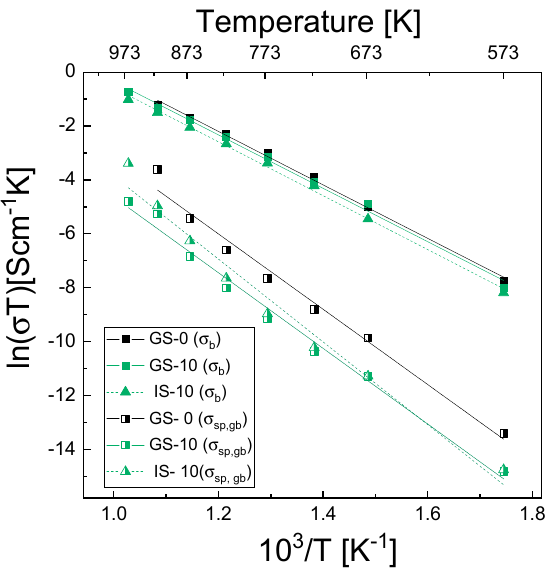
Figure 8. Temperature dependences of the electrical conductivity of grain interiors ( σ b ) and of the specific electrical conductivity of grain boundaries ( σ sp,gb ), expressed in the form of Arrhenius plots for samples GS-0, GS-10 and IS-10.